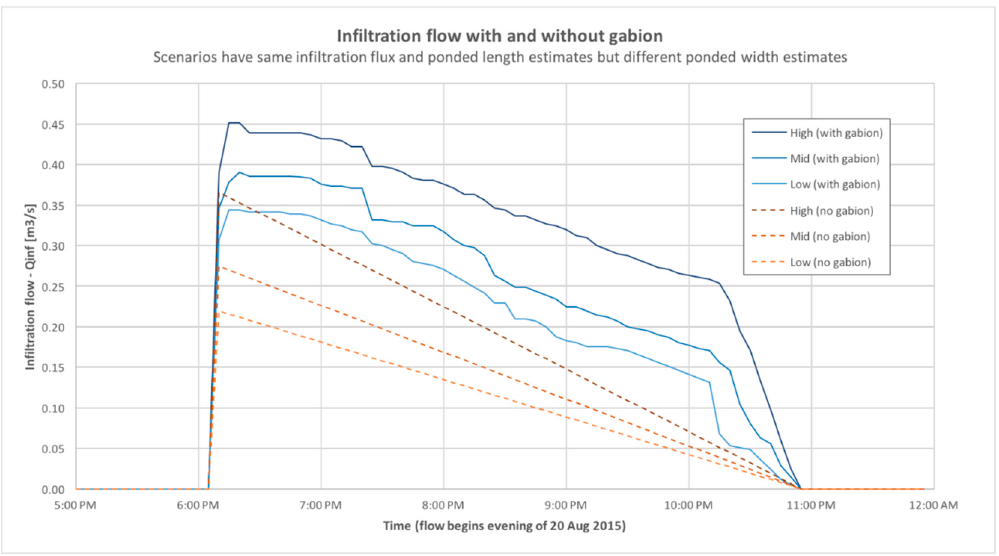
Figure 8. Selected high, intermediate, and low infiltration scenarios with and without a gabion present.